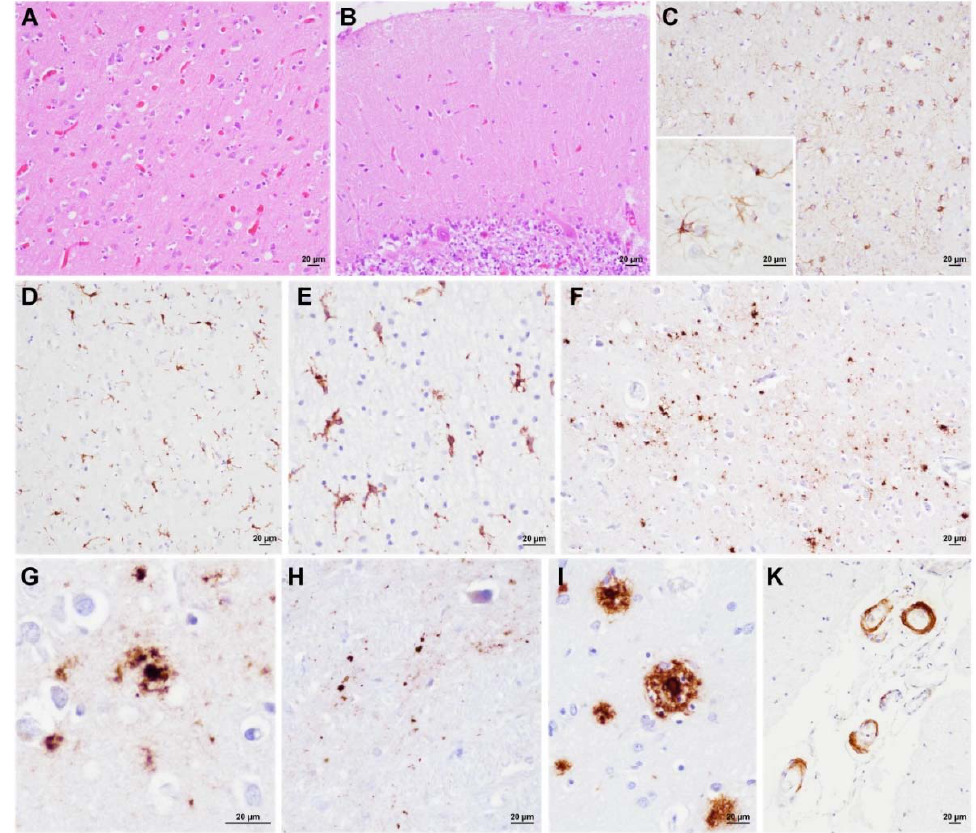
Figure 2. Neuropathological features of VPSPr 129MV (Case#2 ). ( A ) Mild spongiform change in the occipital cortex. ( B ) Lack of spongiform change in the cerebellum. ( C – E ) Severe astrocytic (the lower box shows a detail at higher magnification) and microglial activation in the parietal gray ( C , D ) and white matter ( E ). ( F – H ) PrP dot ‐ like and mini ‐ plaque deposits in the occipital cortex ( F , G ) and thal ‐ amus ( H ). ( G ) PrP mini ‐ plaque that was surrounded by a cluster of fine granules. ( I ) A β core plaque in the frontal cortex. ( K ) Cerebral A β angiopathy in the meningeal vessels of occipital lobe. Haema ‐ toxylin ‐ eosin staining ( A , B ), and immunochemistry for GFAP ( C ), HLA ( D , E ), PrP ( F – H ), and A β ( I , K ).